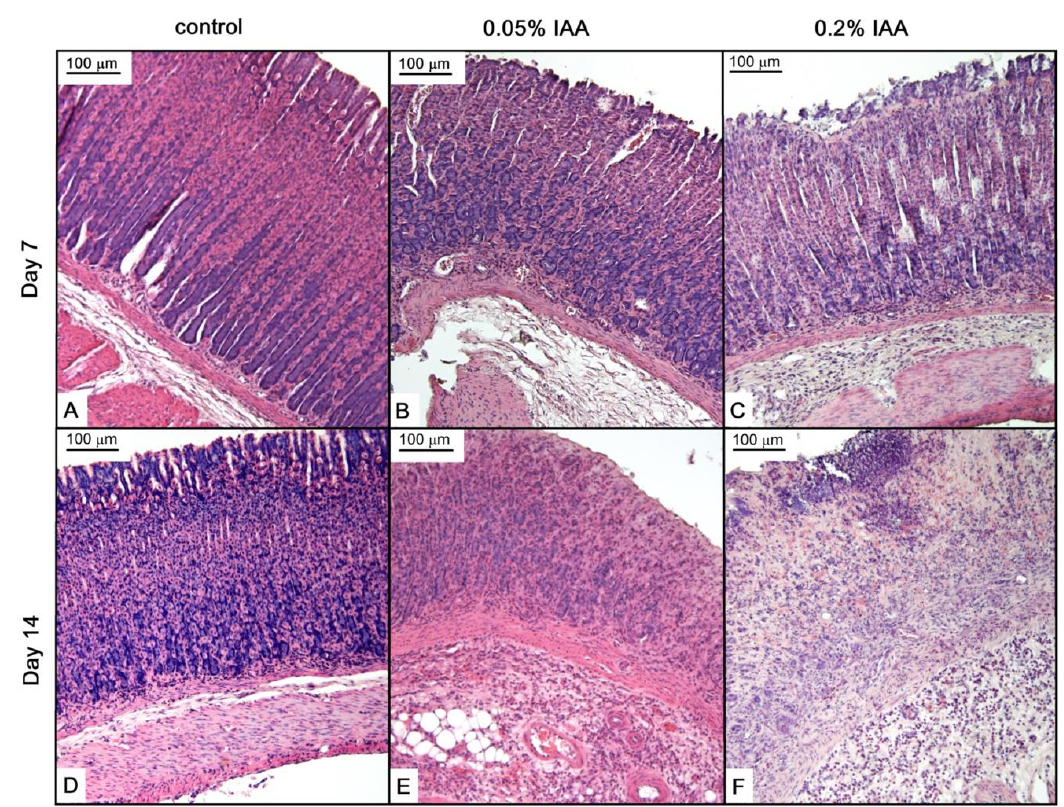
Figure 3. IAA treatment induced microscopic alterations in Wistar rat gastric mucosa. Representative HE-stained microscopic pictures of ( A ), ( D ) control; ( B ), ( E ) 0.05% IAA-treated, and ( C ), ( F ) 0.2% IAA-treated rat gastric mucosa at days 7 and 14, respectively.